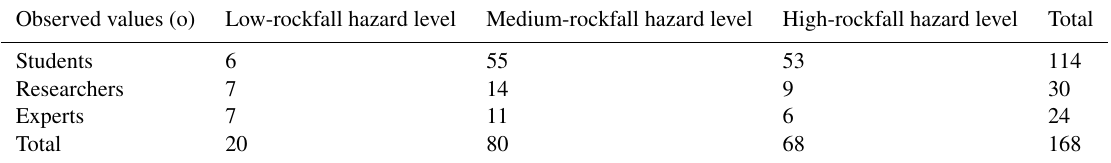
Table 10. Contingency table of the observed values for the chi-square test performed between the level of expertise and the level of rockfall hazard (sector